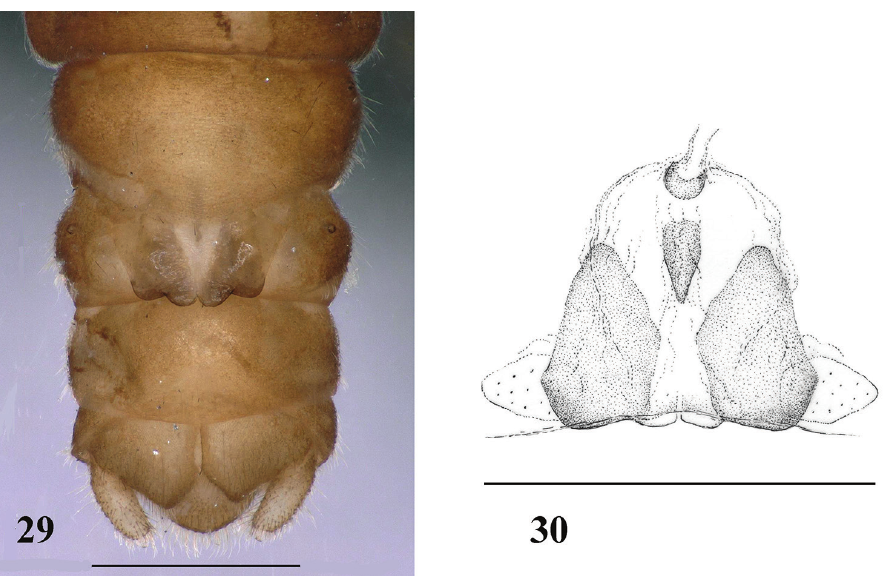
Figures 29–30. Amphinemura unihamata (Wu, 1973), terminalia of adult female. 29 Terminalia in ventral view 30 Inner genitalia, dorsal view. Scale bar: 0.5